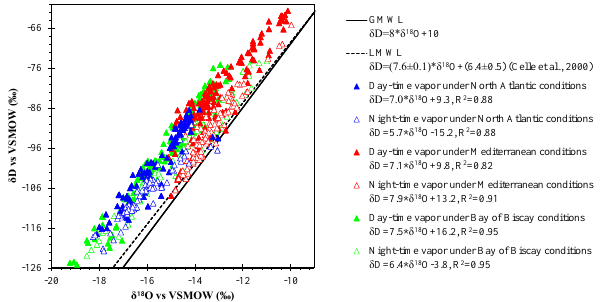
Figure 4. Hourly daytime and night-time isotopic composition of atmospheric water vapour according to air mass origins. For refer- ence, the Global Meteoric Water Line (GMWL) and Local Meteoric Water Line (LMWL) are also plotted.